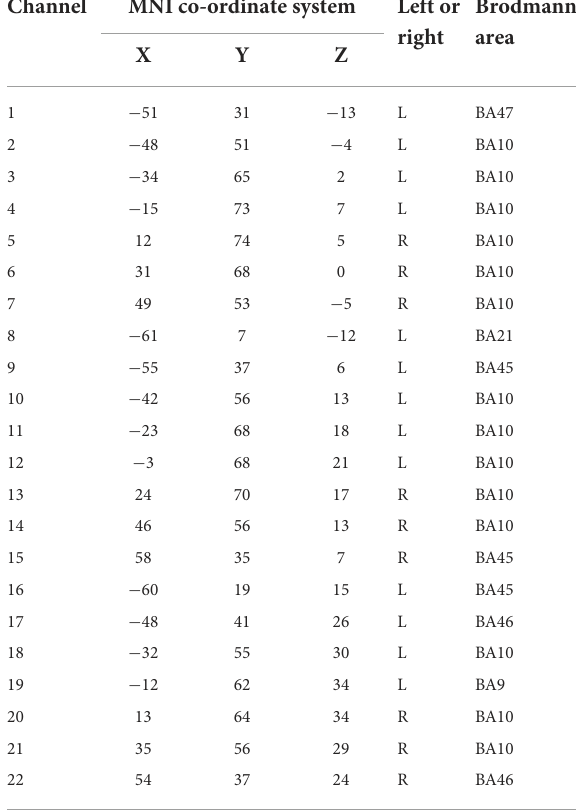
TABLE 1 Demographic and clinical characteristics in patients and controls.